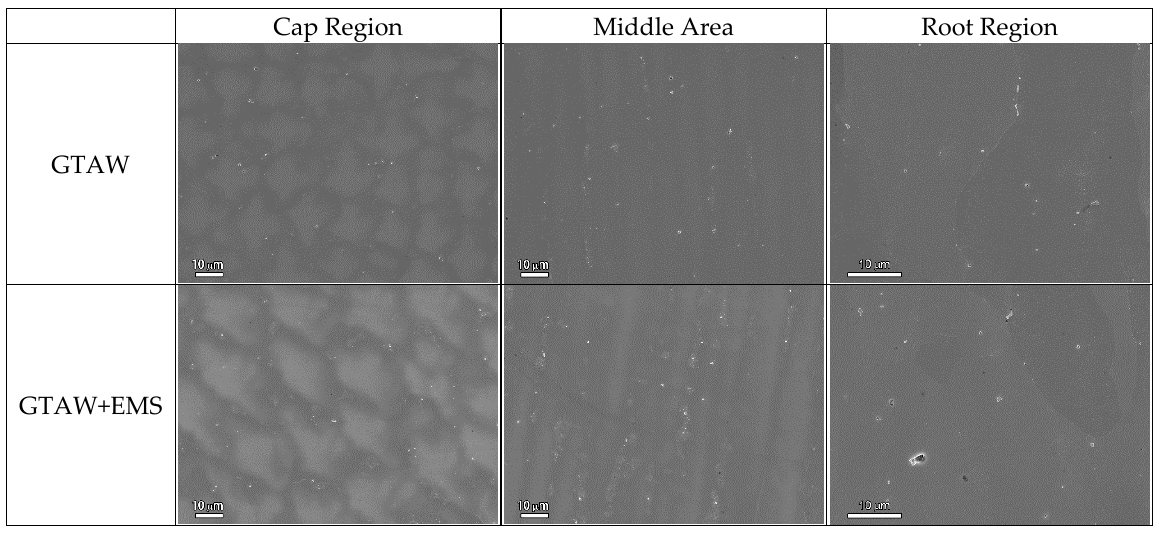
Figure 10. SEM micrographs of Alloy 52M.